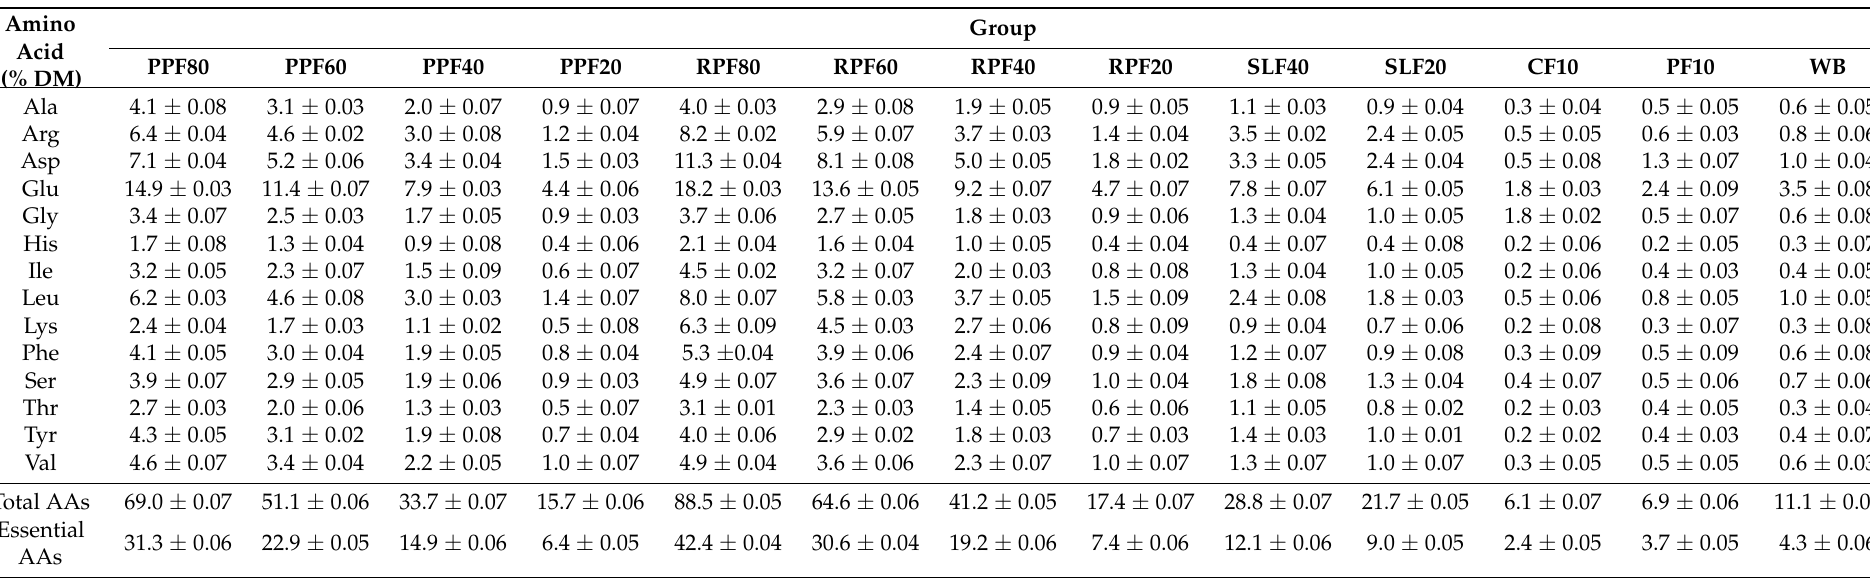
Table 3. Amino acid content (g/100 g of protein) of the diets used for Tenebrio molitor larvae feeding. Data are presented as mean ± standard deviation, n =